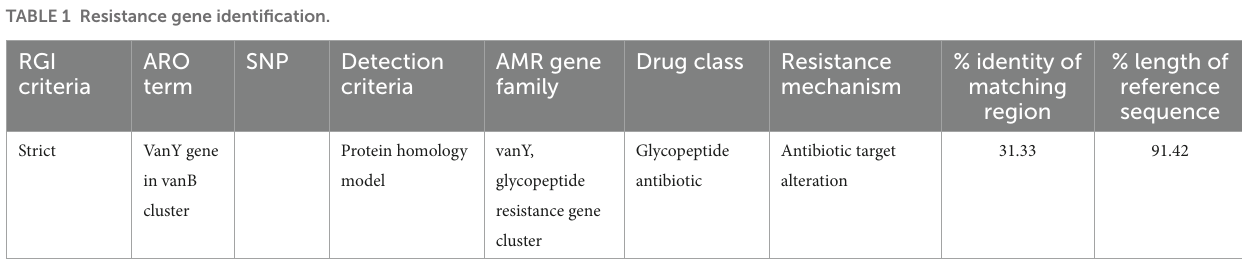
TABLE 1 Resistance gene